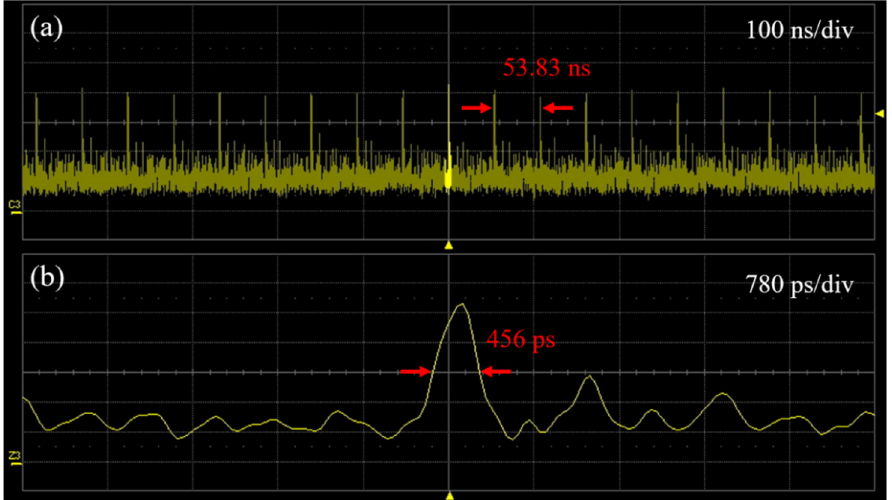
Figure 7. Characteristic parameters of the mode-locked operation laser. ( a ) Typical mode-locked pulse sequence under 100 ns/div and ( b ) individual pulse under 780 ps/div.